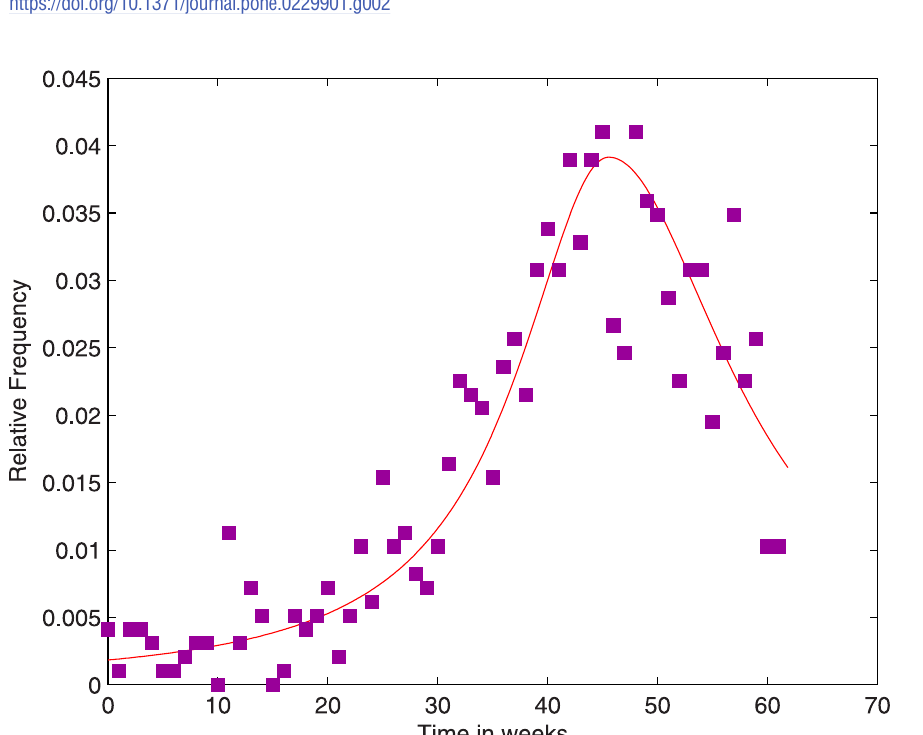
Fig 3. Scatter diagram of the relative number of cases over the outbreak period and the density plot.